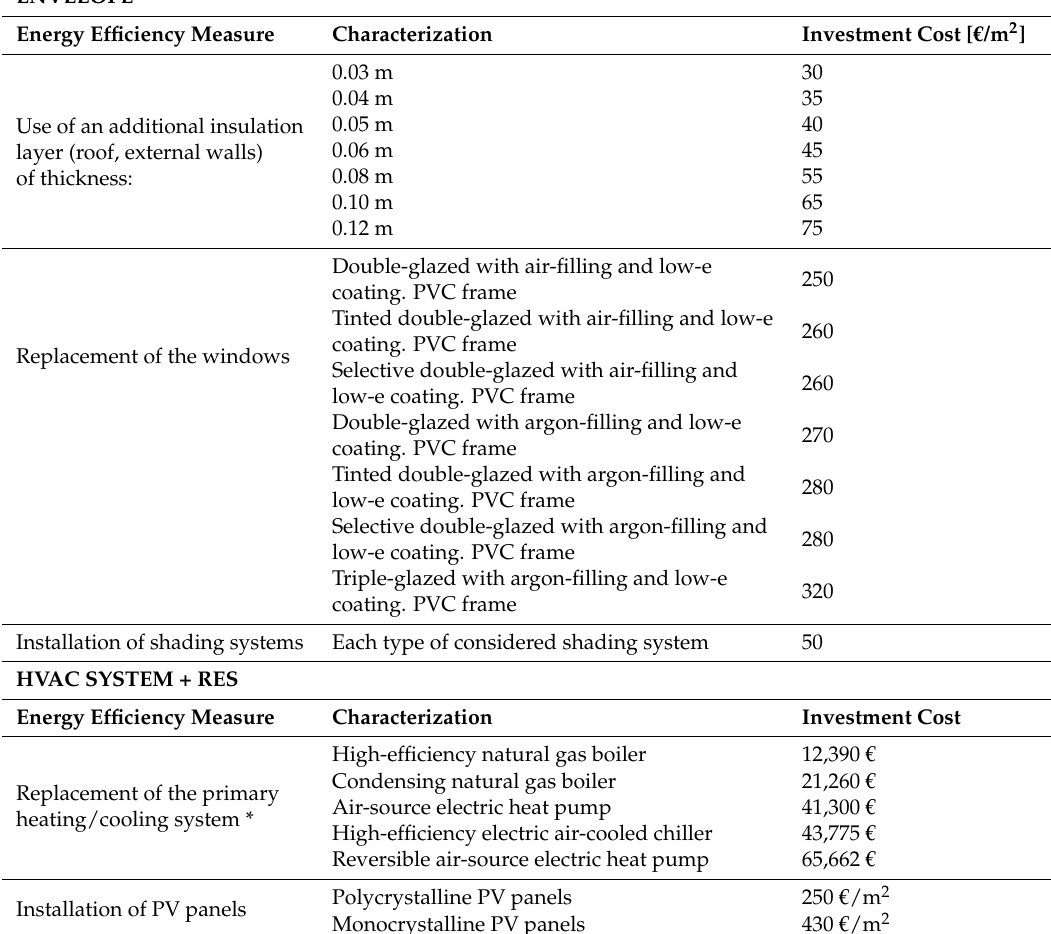
Table 11. Investment costs of energy retrofit